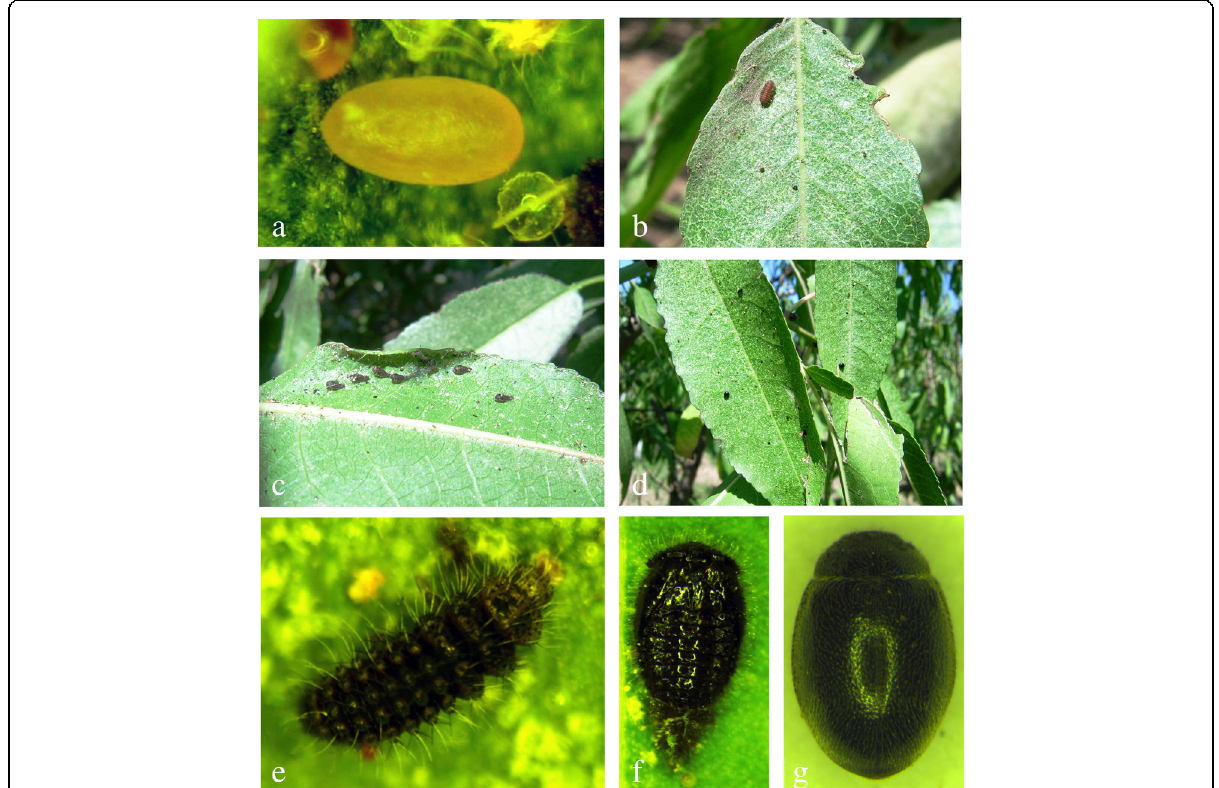
Fig. 1 Life stages of Stethorus aptus feeding on Panonychus ulmi. ( a ) Egg. ( b ) Grub feeding on P. ulmi. ( c ) Pupa on leaf surface. ( d ) Adults feeding on P. ulmi. ( e - g ) Magnified picture of grub, pupa and adult